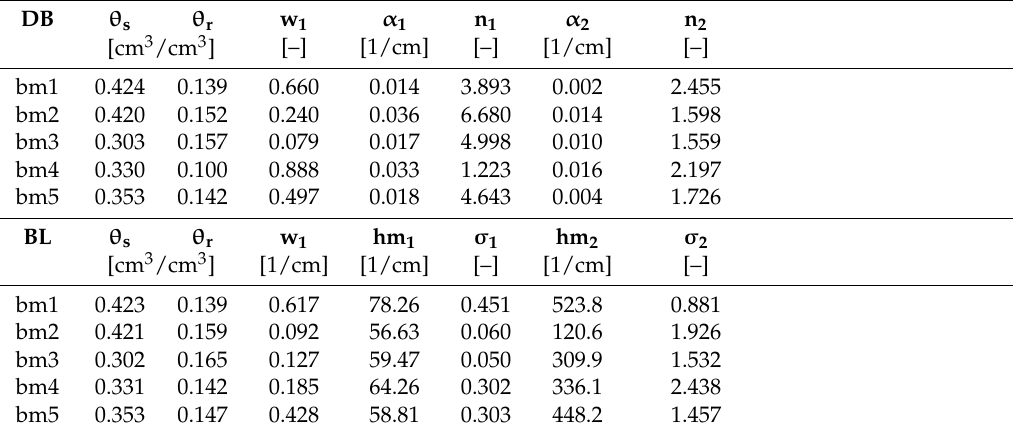
Table 5. Fitted soil water retention curve parameters of the marsh clay (mc): BC model [18],